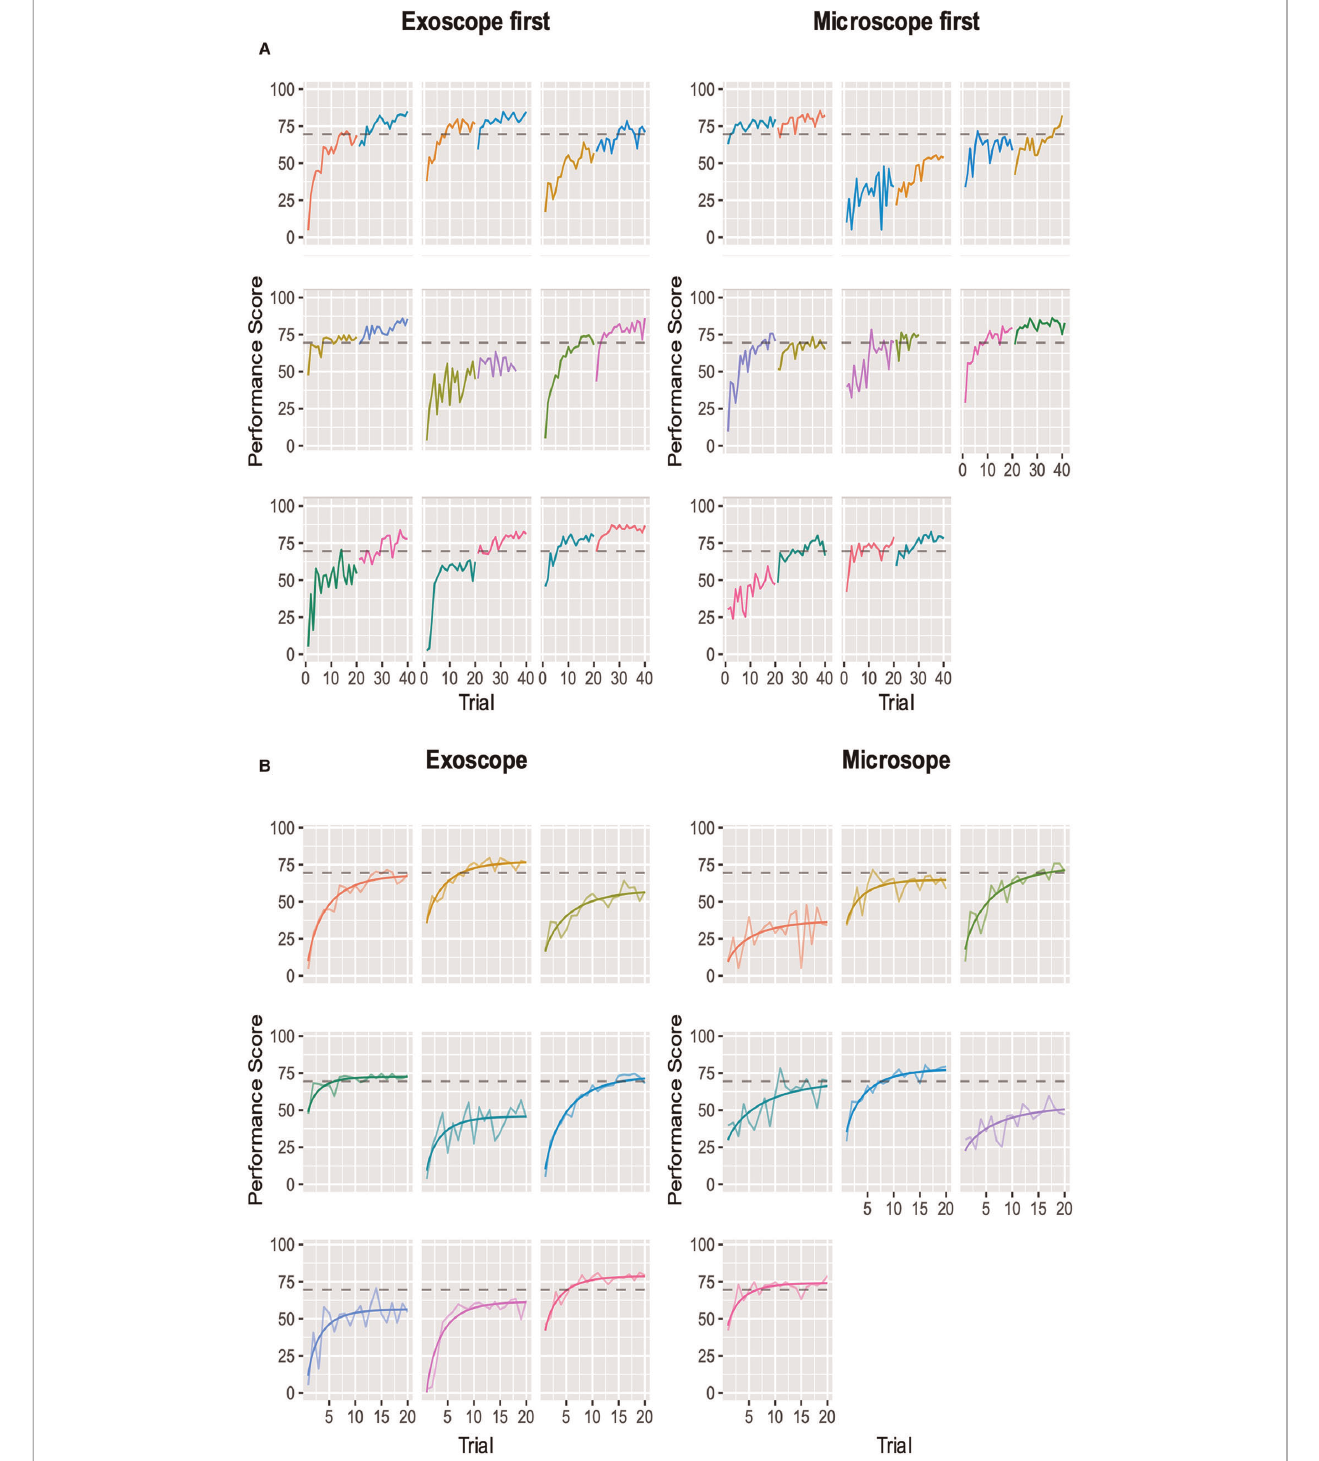
FIGURE 2 | Composite performance score of novice surgeons completing the microsurgical grape dissection task with a threshold for expert performance (gray dashed line 70; 0 – 100). Each graph represents a separate novice. In total, participants completed 20 repetitions of the task on each device consecutively. ( A ) Novice surgeons ’ performance scores plotted against the number of trials performed, with the group starting with the ORBEYE and microscope. The fi rst colored graph represents the fi rst device, and the second colored graph represents the crossover to the second device. ( B ) Modeled learning curves using the modi fi ed Weibull